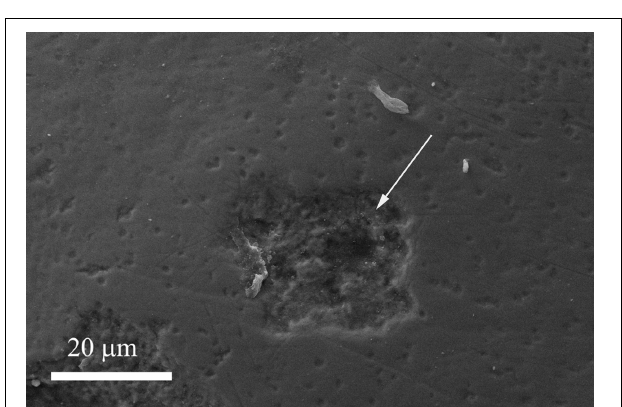
(Roveri et al., 2009a). Biomimetic carbonate hydroxyapatite